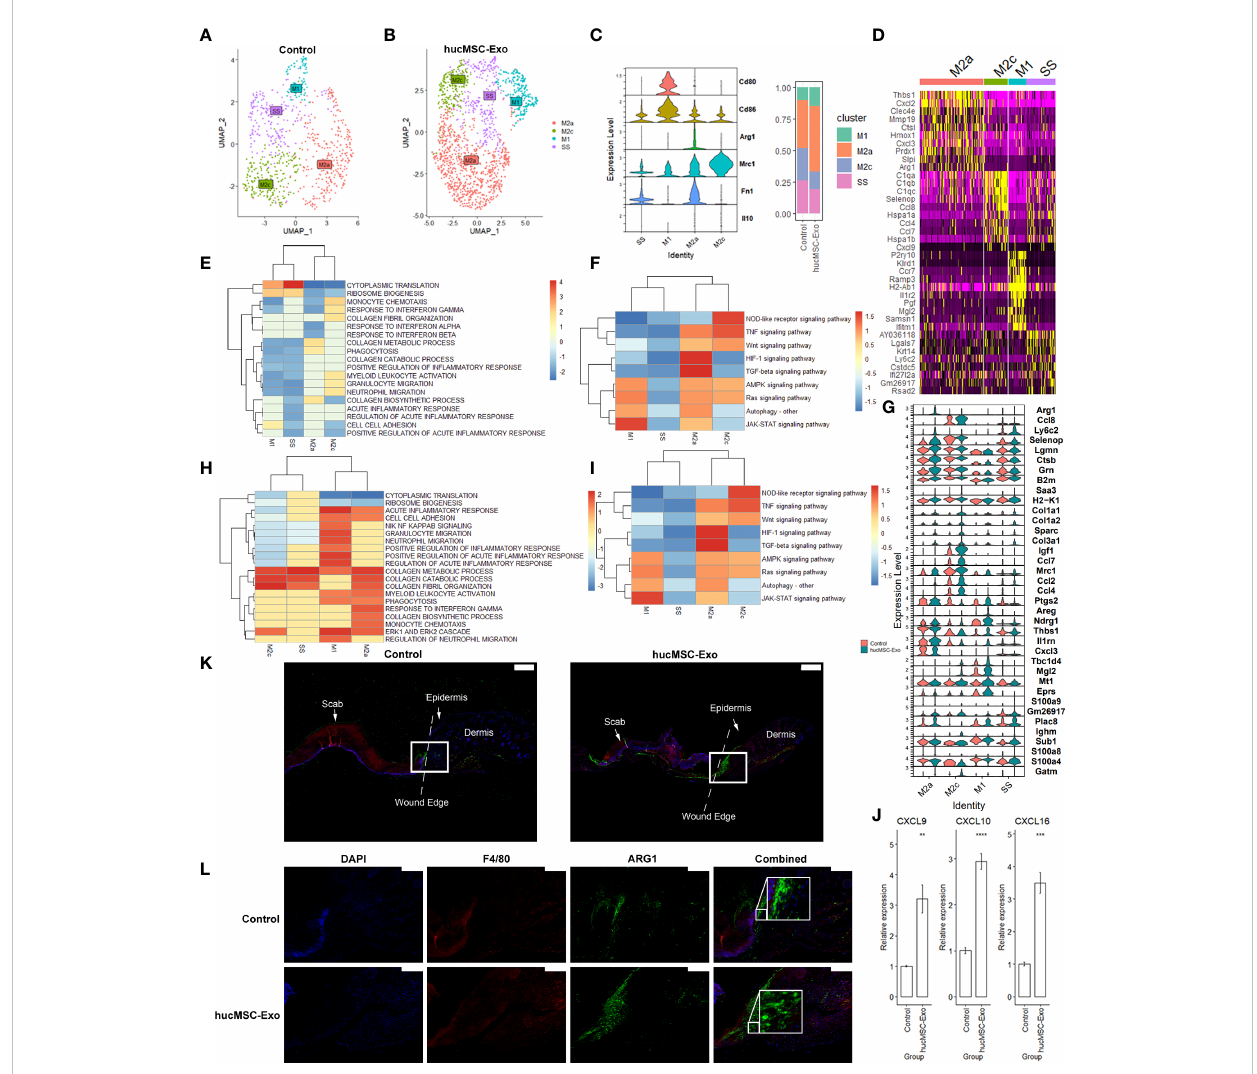
FIGURE 4 HucMSC-Exosomes induce functional changes in macrophages. (A) 2D scatterplot based on UMAP reduction of macrophage coordinates. (B) Stacked violin plot of macrophage subcluster annotation markers. (C) Stacked bar plot of macrophage subcluster abundance ratio. (D) Heatmap of top expressed marker of macrophage subclusters. (E) GSEA Heatmap of genes expressed by macrophages. (F) KEGG Heatmap of genes expressed by macrophages. (G) Stacked violin plot of top differentially expressed genes (DEGs) of macrophages following hucMSC-Exosomes exposure. (H) GSEA Heatmap of macrophage DEGs following hucMSC-Exosomes exposure. (I) KEGG Heatmap of macrophage DEGs following hucMSC- Exosomes exposure. (J) Quantitative RT-PCR analysis of the Cxcl9 , Cxcl10 , and Cxcl16 mRNA expressions in peri-wound samples. Two-tailed unpaired t-test (n = 6). Error bar: mean standard error. GAPDH was used as the reference gene. **p < 0.01, ***p < 0.001, ****p < 0.0001. (K) Merged immuno fl uorescence staining with ARG1 antibody (green), F4/80 antibody (red) and nuclear staining (DAPI). The scale bar is 500 µm. White square indicate the region of (L) . (L) Immuno fl uorescence staining with ARG1 antibody (green) and F4/80 antibody (red). Nuclear staining (DAPI) and merged images are also shown in the diagram. The scale bar is 200